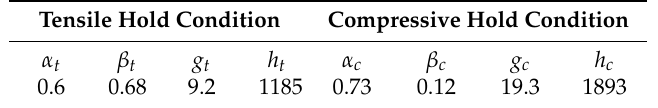
Table 5. Modified MCB model parameters identified from CFI lives at various hold